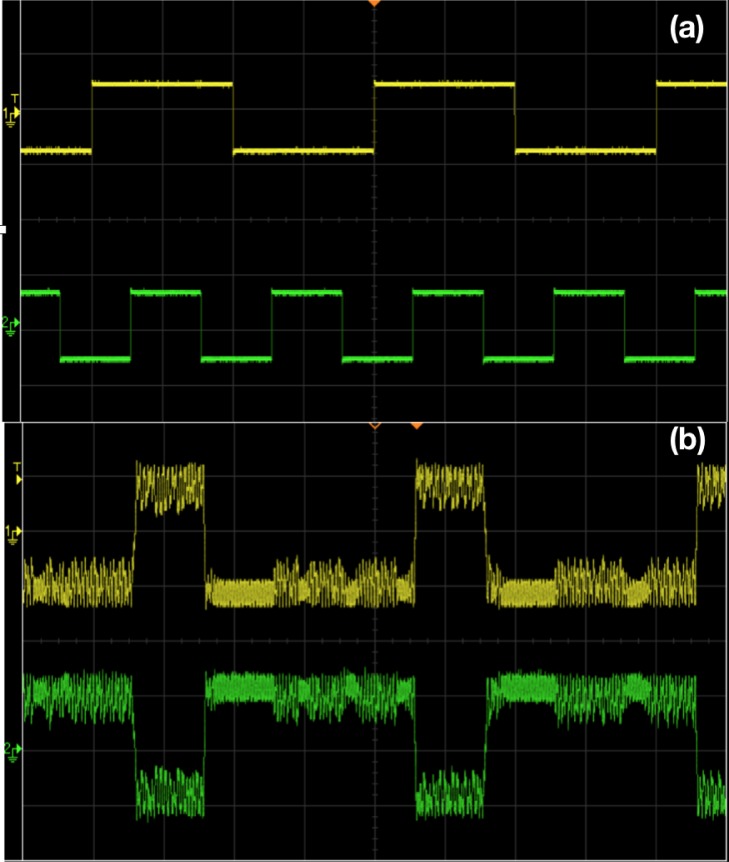
Realization of AND/NAND logic gates through chaotic attractor hopping in electronic circuit experiments.Panel (a) shows stream of inputs I1 and I2 (which take value −10 mV when logic input is 0 and value 10 mV when logic input is 1). Panel (b) shows the voltage V(t) (yellow) clearly indicating a logical AND output (with V(t) > 0 being logic output 1, and V(t) < 0 being logic output 0). The output voltage VL (green) yields the complementary NAND logic gate response. The amplitude A of the sinusoidal signal is 150mV and frequency is 8890 Hz. The bias voltage b, is fixed as −10 mV. For panel (a), the scale in the traces are: 20 mV/Div (Y-axis) and 5 mS/Div (X- axis). For panel (b), the scale in the traces are: 100 mV/Div (Y-axis) and 5 mS/Div (X- axis).